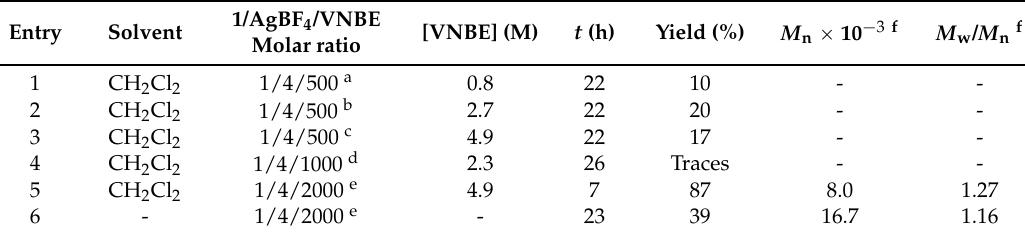
Table 4. Polymerization of 5-vinyl-2-norbornene (VNBE) with the catalytic system 1 /AgBF 4